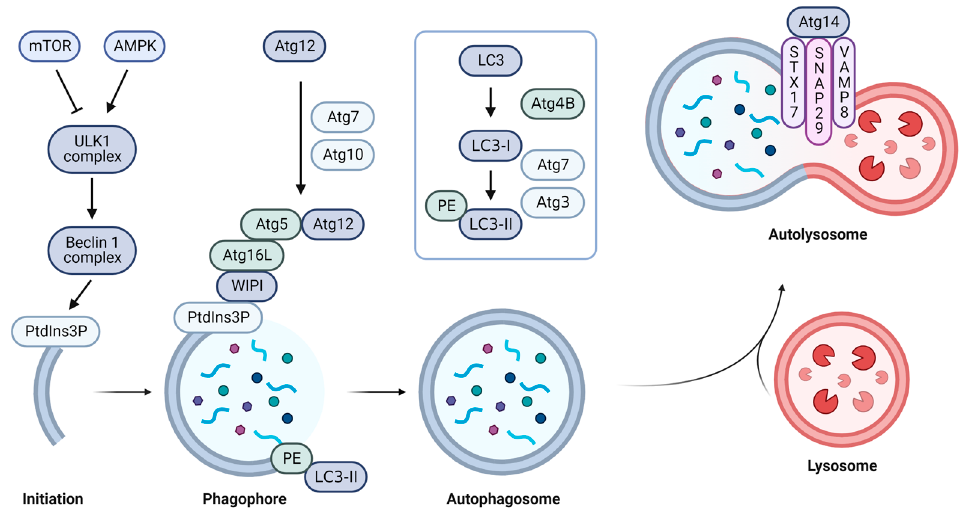
Figure 2. Overview of the canonical autophagy pathway. Canonical autophagy is initiated by signaling according to low intracellular energy. The phagophore is elongated by using the ubiquitin-like conjugation system. The elongated phagophores form autophagosomes which fuse with lysosomes. This figure was created with biorender.com and accessed on 17 January 2023.